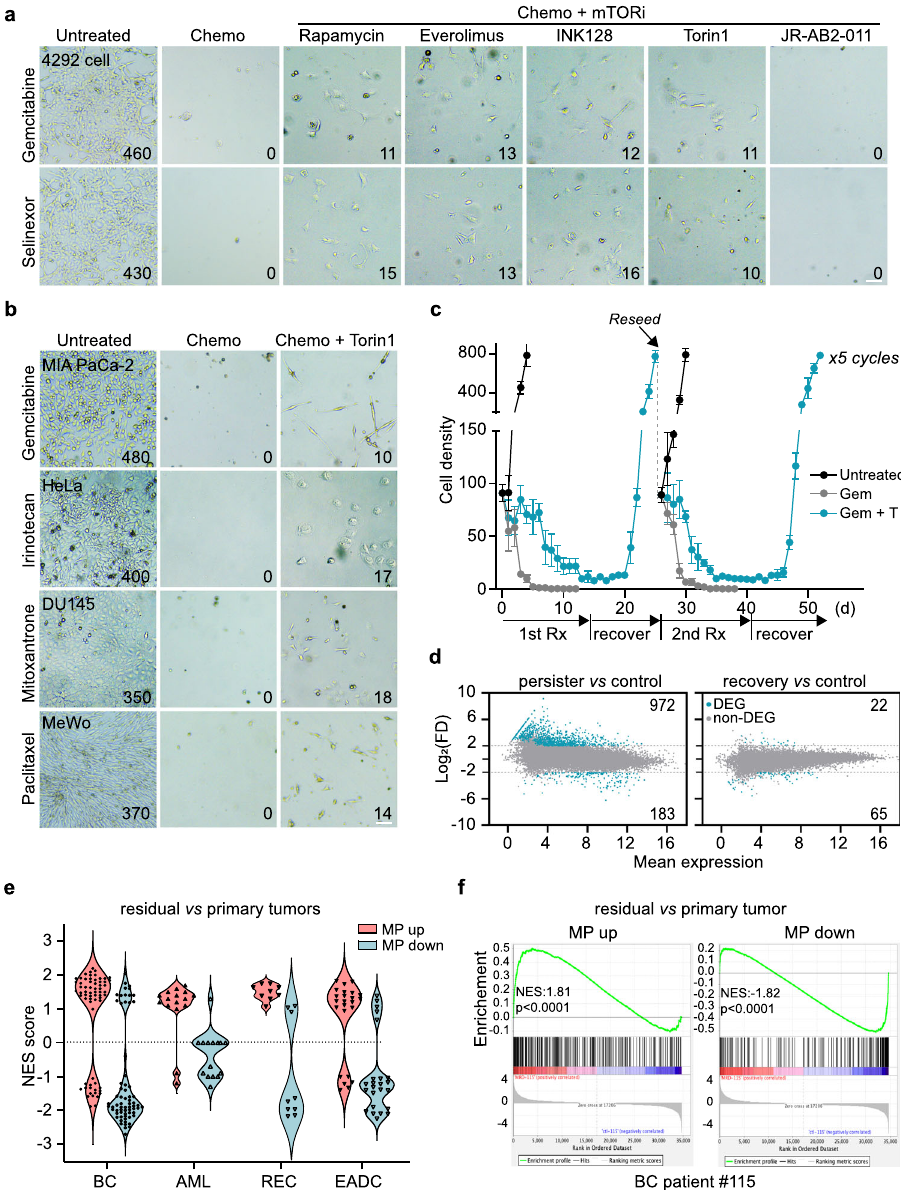
Fig. 2 | mTOR inhibition induces reversible chemoresistant persisters. a 4292 cells were treated with chemotherapeutic agents (2 μ M gemcitabine, 2 μ M seli- nexor), or chemotherapeutic agents plus a panel of mTOR inhibitors (rapamycin, everolimus, INK128, and Torin1 at 100nM, and JR-AB2-011 at 1 μ M) for seven days.